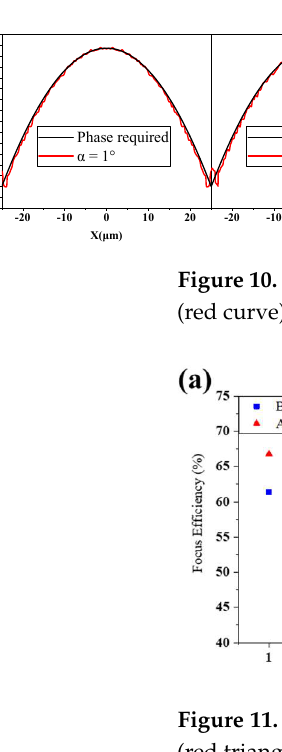
Figure 9. Simulated relative E-field intensity profiles in the xz-plane of the metalenses with different values of α designed by MTD method.